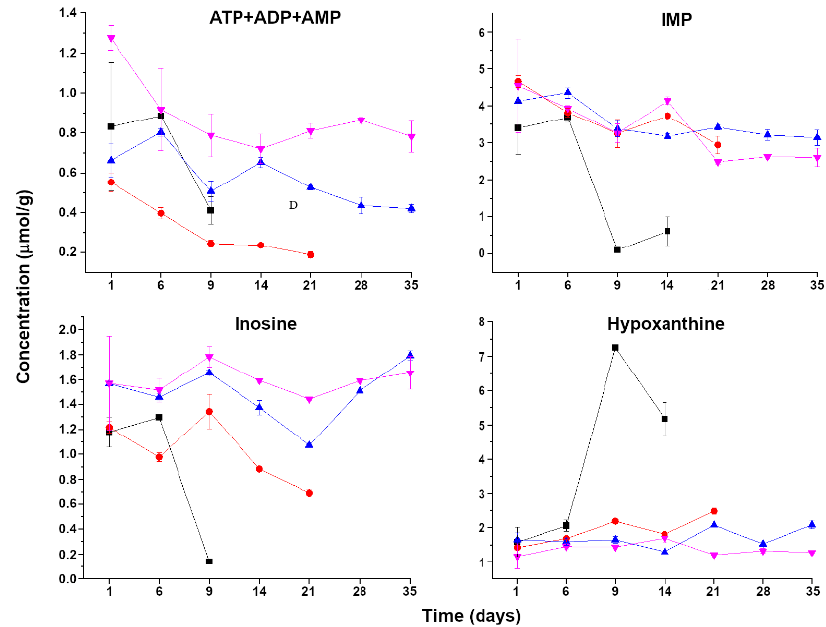
Figure 3. Changes during storage in nucleotide concentrations in striped prawn flesh control samples (black squares) and in samples treated with HHP at 400 (red circles), 500 (blue upward triangles), and 600 MPa (purple downward triangles).